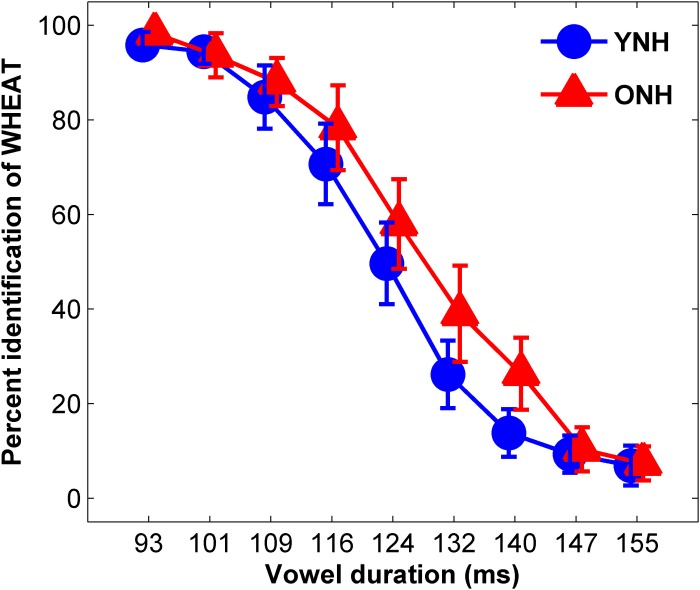
Average identification functions for percentage of trials identified as WHEAT as a function of vowel duration for each participant group. Younger normal-hearing (YNH, red) participants exhibited sharper slopes for the identification functions than did older normal-hearing (ONH, blue) participants, indicating a clearer distinction between WHEAT and WEED. Error bars: ± 1 standard error.